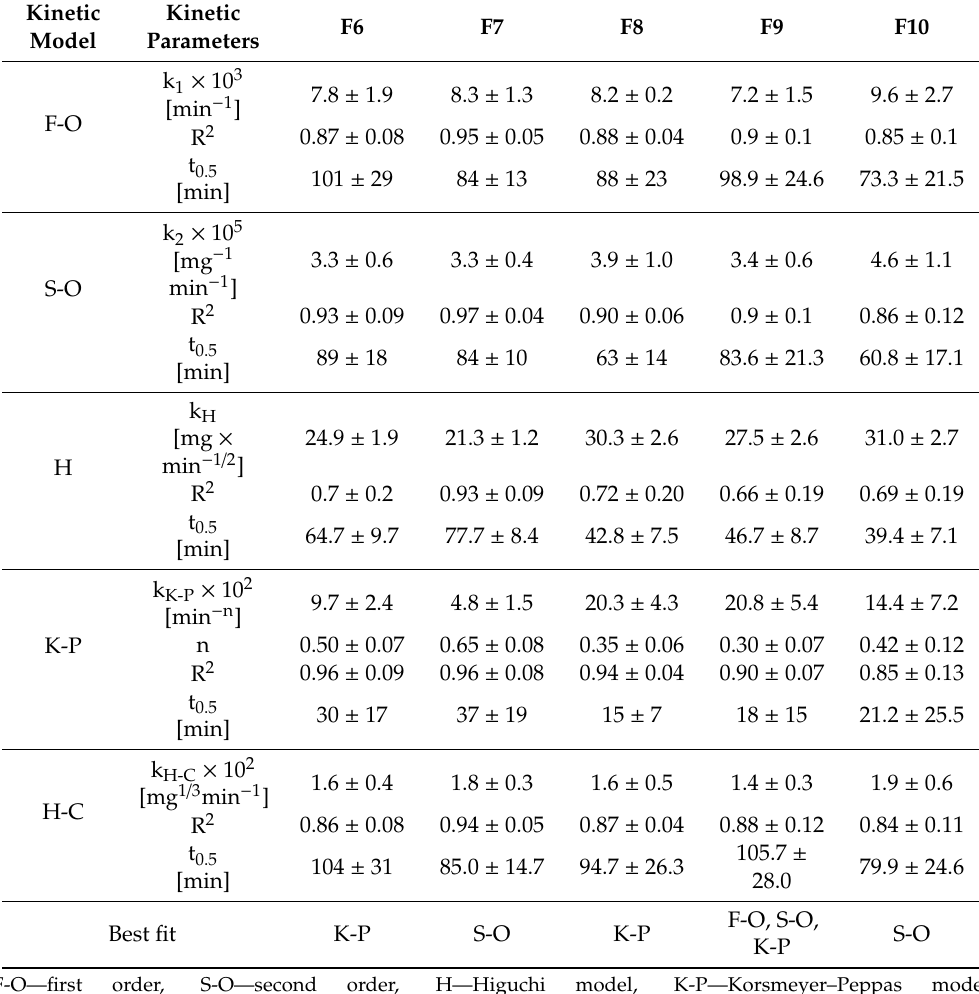
Table 1. The obtained kinetic parameters of the first stage of the release.